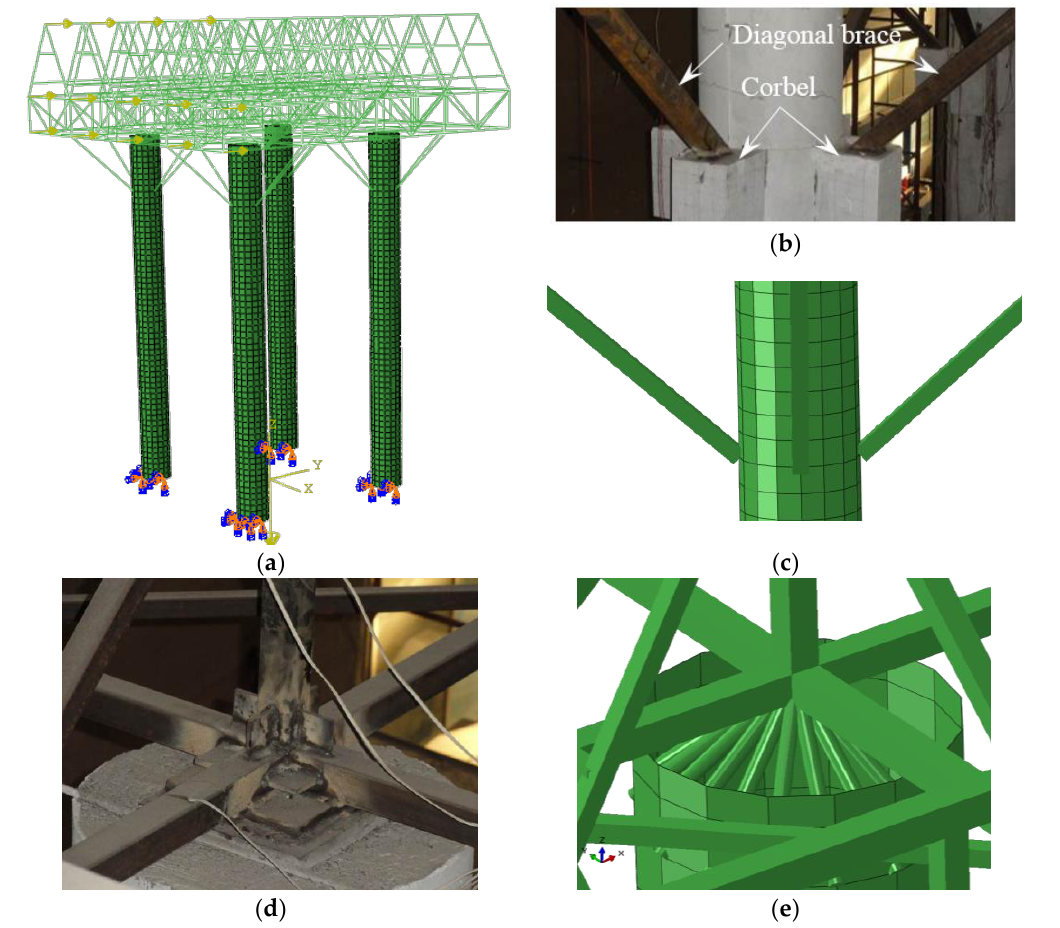
Figure 7. Schematic of finite element (FE) model for the test specimen: ( a ) Whole model; ( b ) Photo of actual connection between the diagonal brace and column; ( c ) Simplification of the brace-to-column connection; ( d ) Photo of actual truss-to-column connection; ( e ) Simplification of the truss-to-column connection.